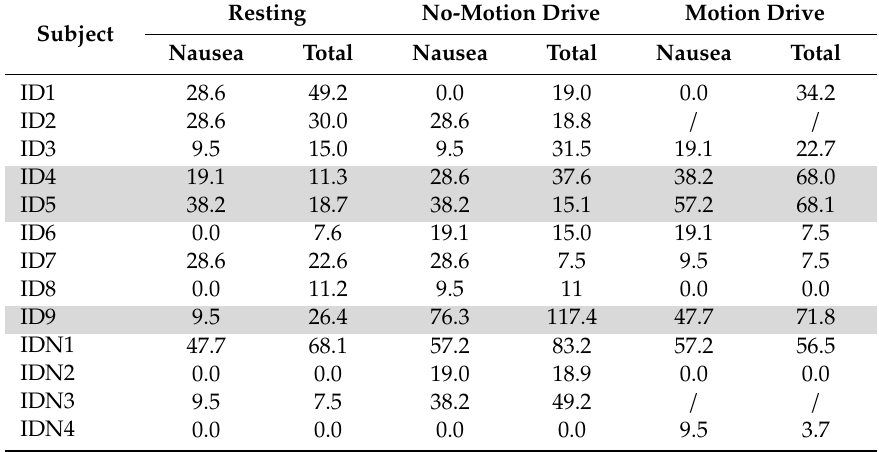
Table 1. Simulator Sickness Questionnaire (SSQ) results for 13 subjects. ID1-ID9 are subjects included in the EGG analysis. IDN1-IDN4 are subjects excluded from the study (see the main text for more details). Shaded subjects experienced higher SS symptoms, as revealed by the SSQ.